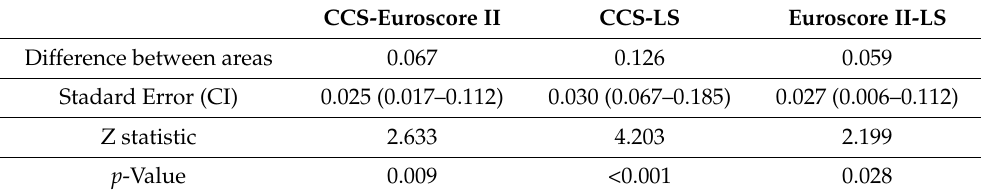
Table 7. Comparison between ROC curves by DeLong’s